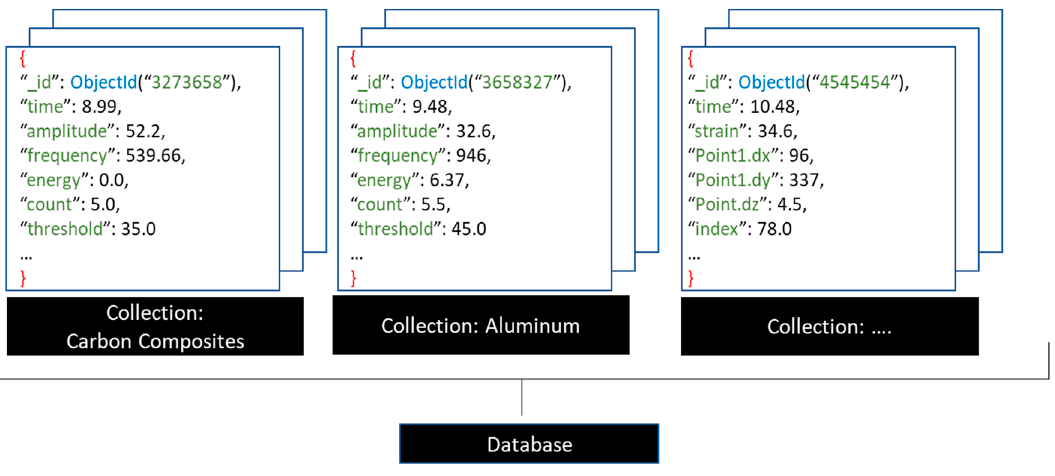
Figure 9. Database structure used in the IIoT system.